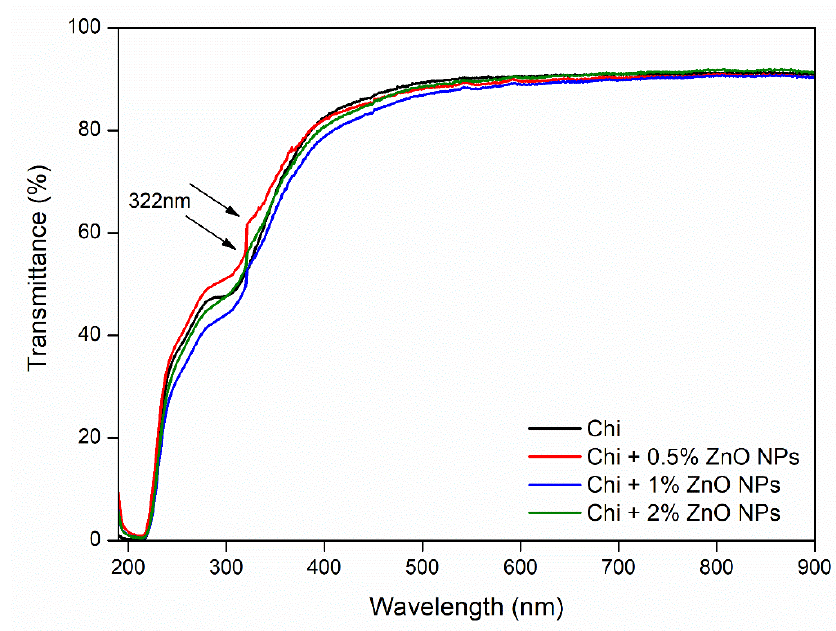
Figure 3. Bionanocomposites transparency. Chi: chitosan; ZnO NPs: zinc oxide nanoparticles.